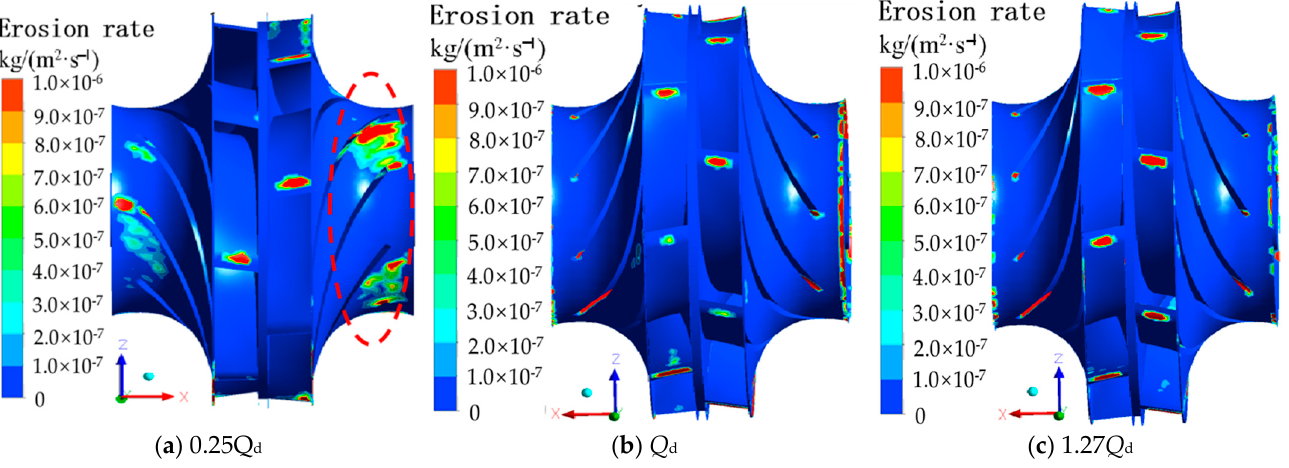
Figure 11. Distribution of erosion in the impeller under different flow rate conditions.